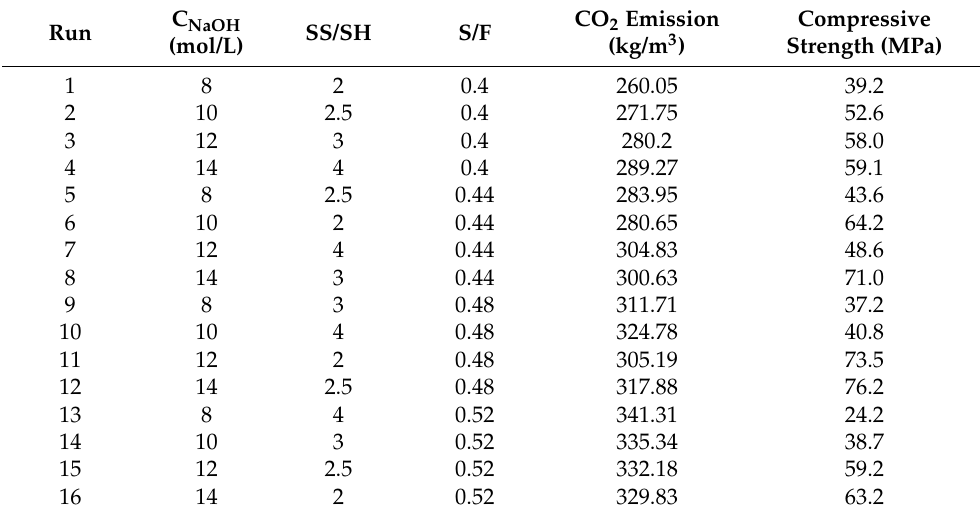
Table 4. Mix proportion of fly ash